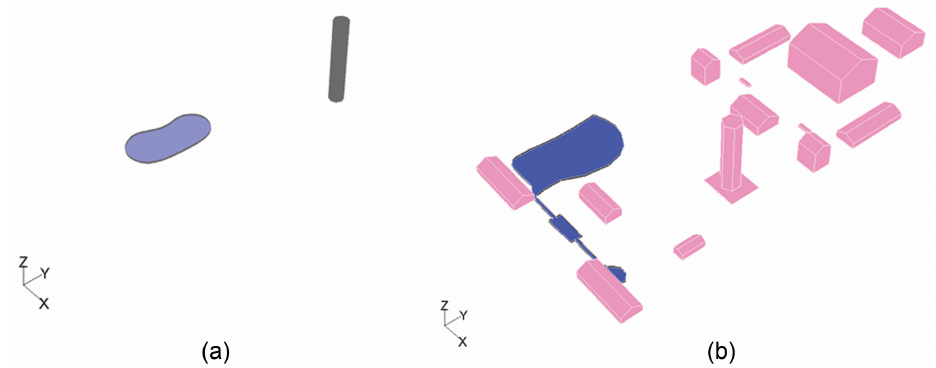
Figure 6. Gambit built a simplified plan: before ( a ) and after ( b ) the transformation of the model.